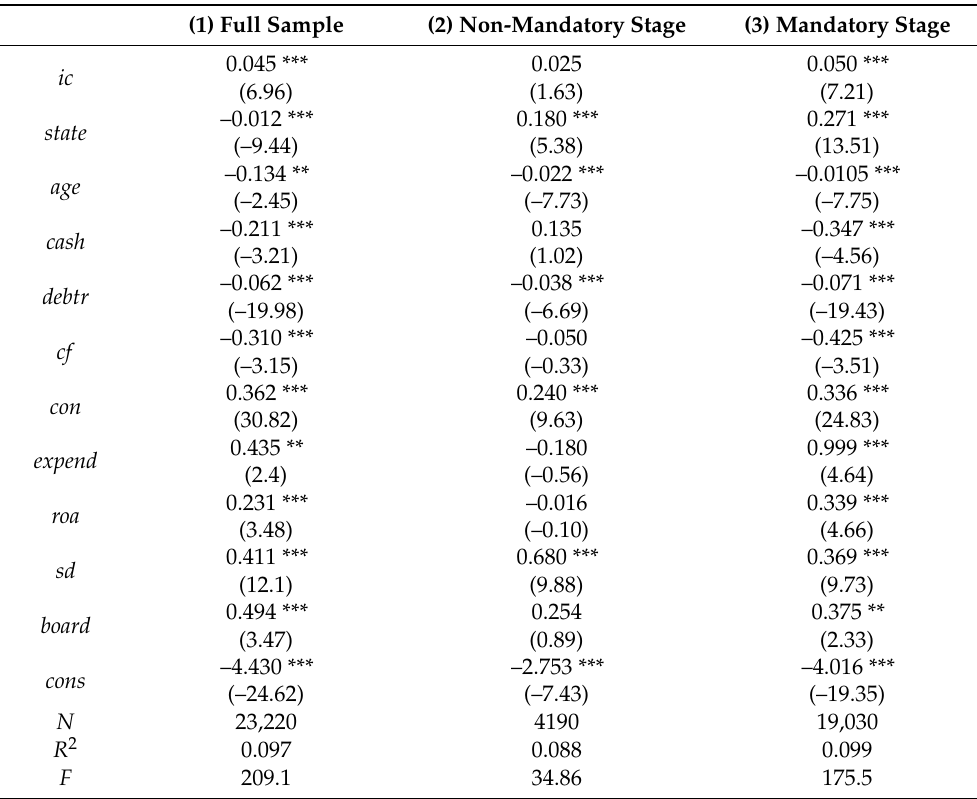
Table 3. Impact of internal control on green